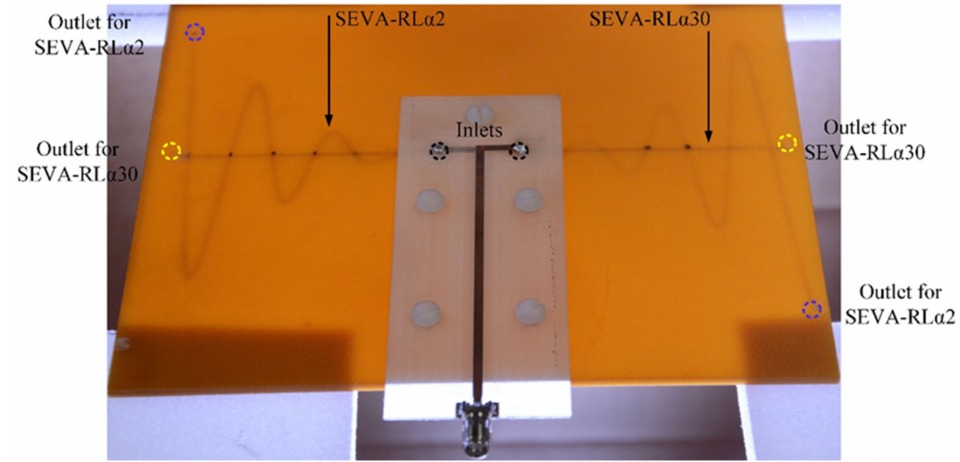
Figure 4. Fabricated ML-SEVA and feed network aligned and attached with nylon